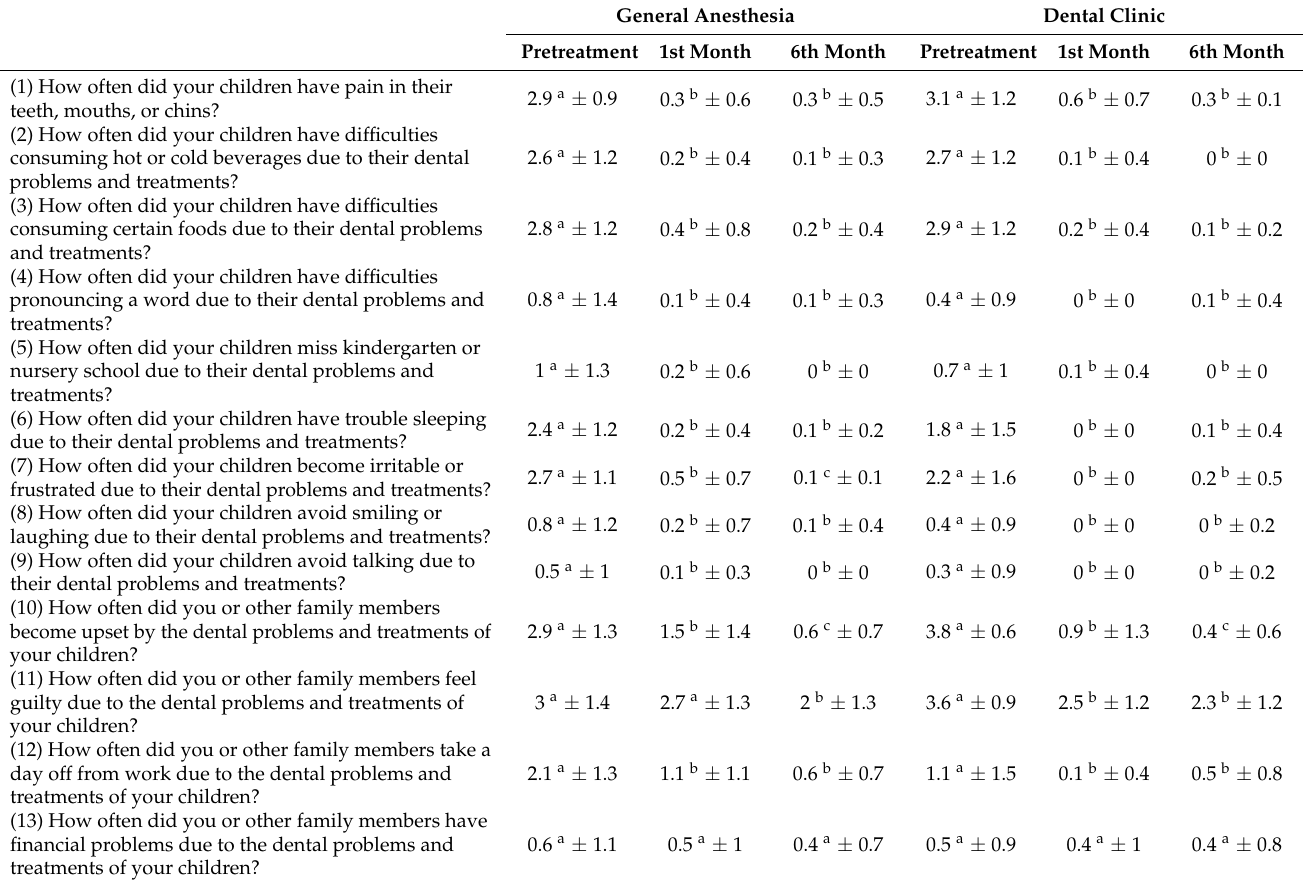
Table 3. Mean scores of ECOHIS items in GA and DC groups obtained at the different stages (Mean ± Standard